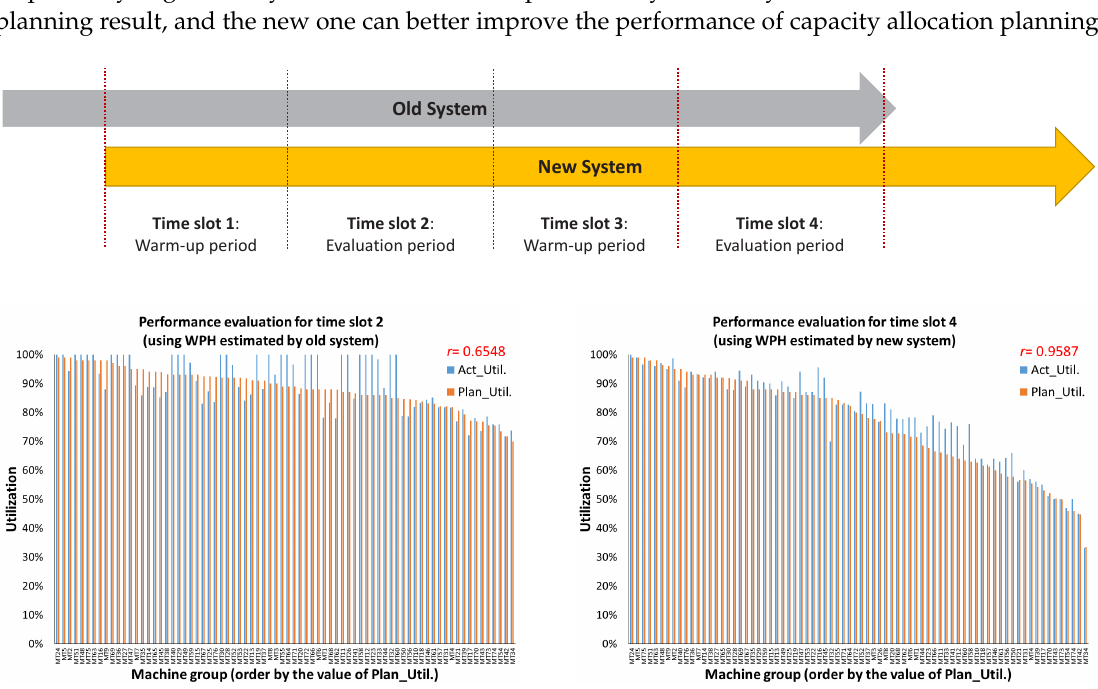
Figure 12. Performance comparison within the period of parallel